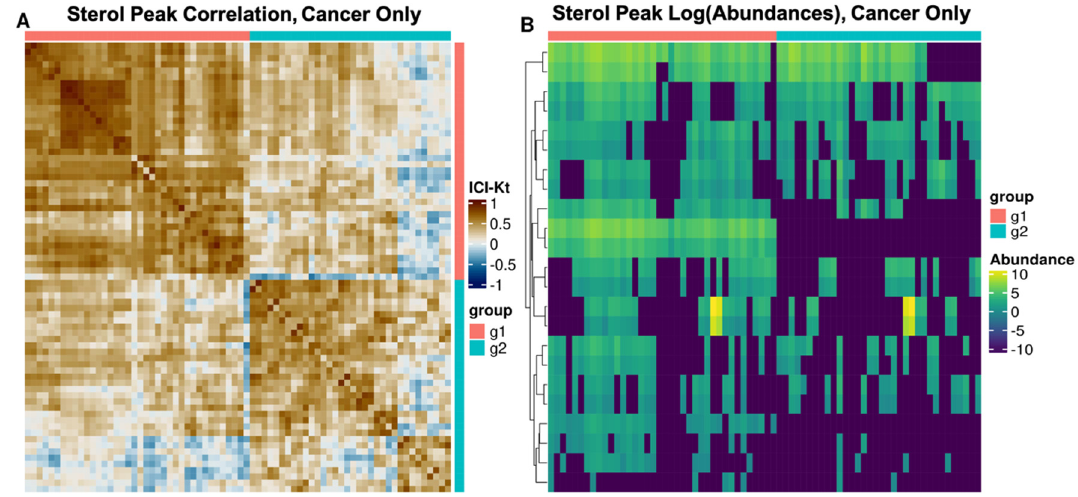
Figure 5. Sterol-only cancer sample-sample correlation heatmap. ICI-Kendall-tau correlation heatmap ( A ) and abundance heatmap across samples ( B ). Both plots show that the cancer samples can be separated into two groups based on the sample-sample correlation; however, these groups do not correspond to a histological subtype of NSCLC. As indicated in Figure 4, there also appear to be two main groups of sterol peaks in ( B ).